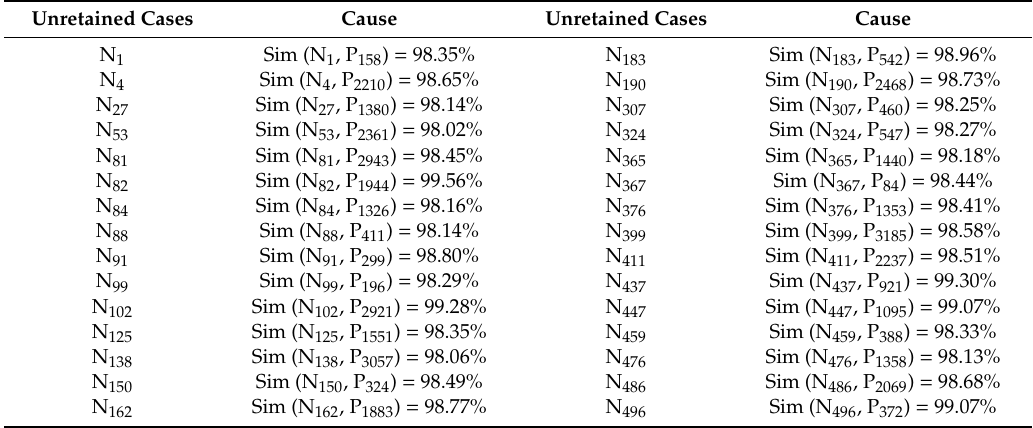
Table 10. List of unretained new